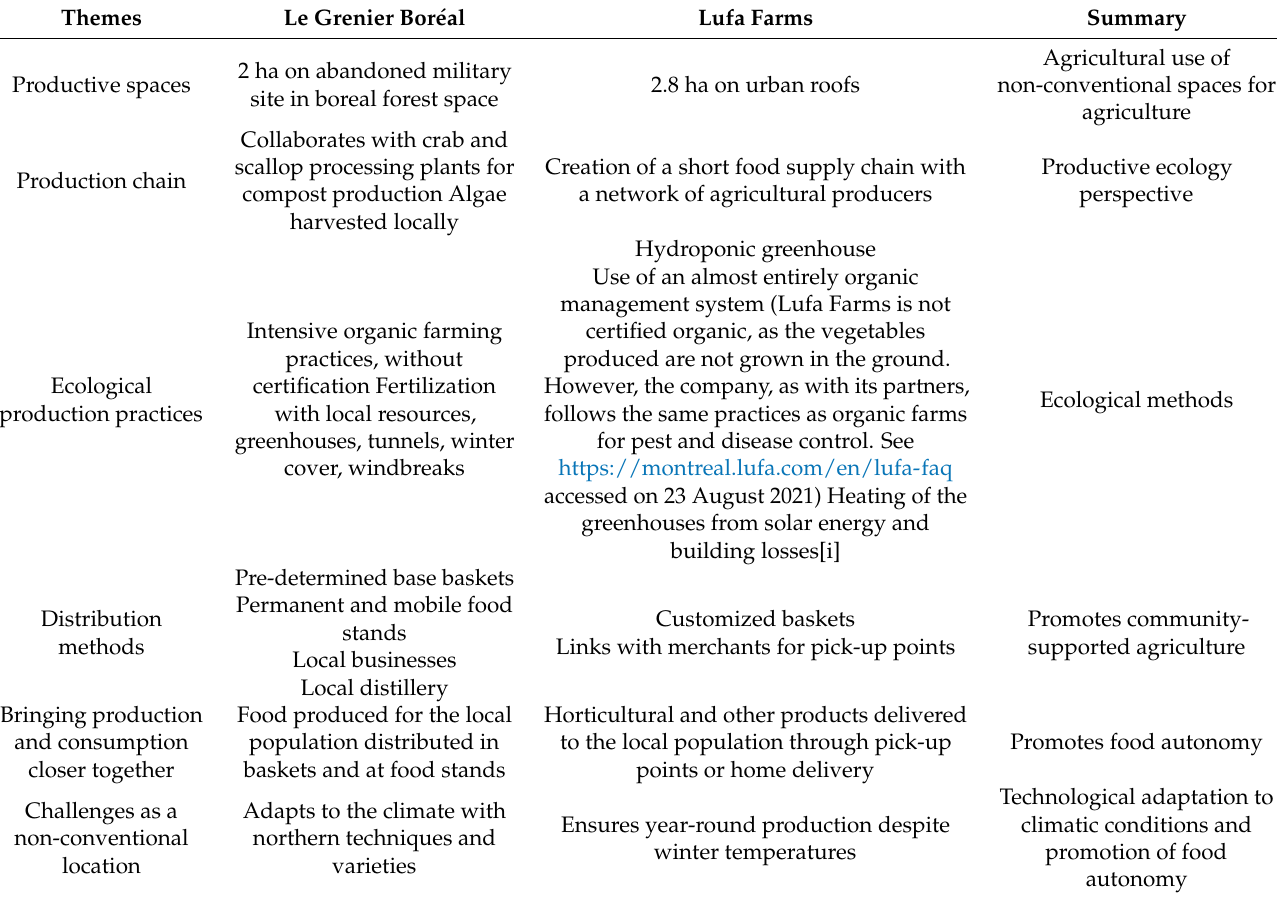
Table 1. Contribution of Le Grenier bor é al and Lufa Farms to food